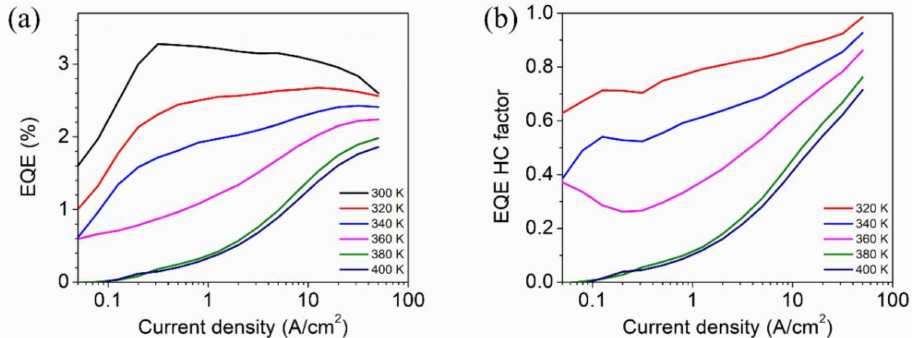
Figure 2. Temperature-dependent (300 K to 400 K) ( a ) EQE vs. J ; ( b ) EQE HC factor vs. J . These figures are reproduced from [7], with the permission of AIP Publishing.